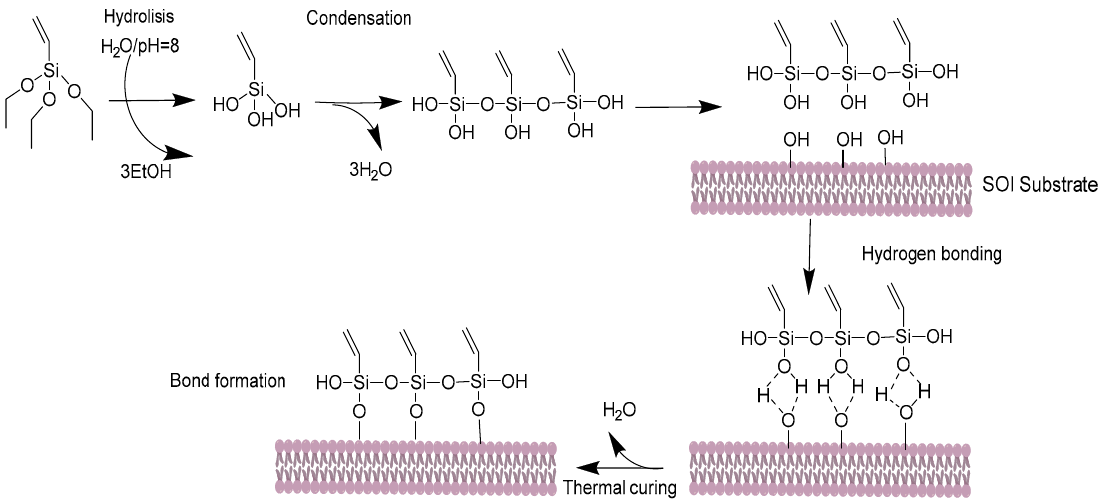
Figure 2. Steps of the silanization process used to create a vinyl-terminated monolayer on the surface of the SOI sensing structures.